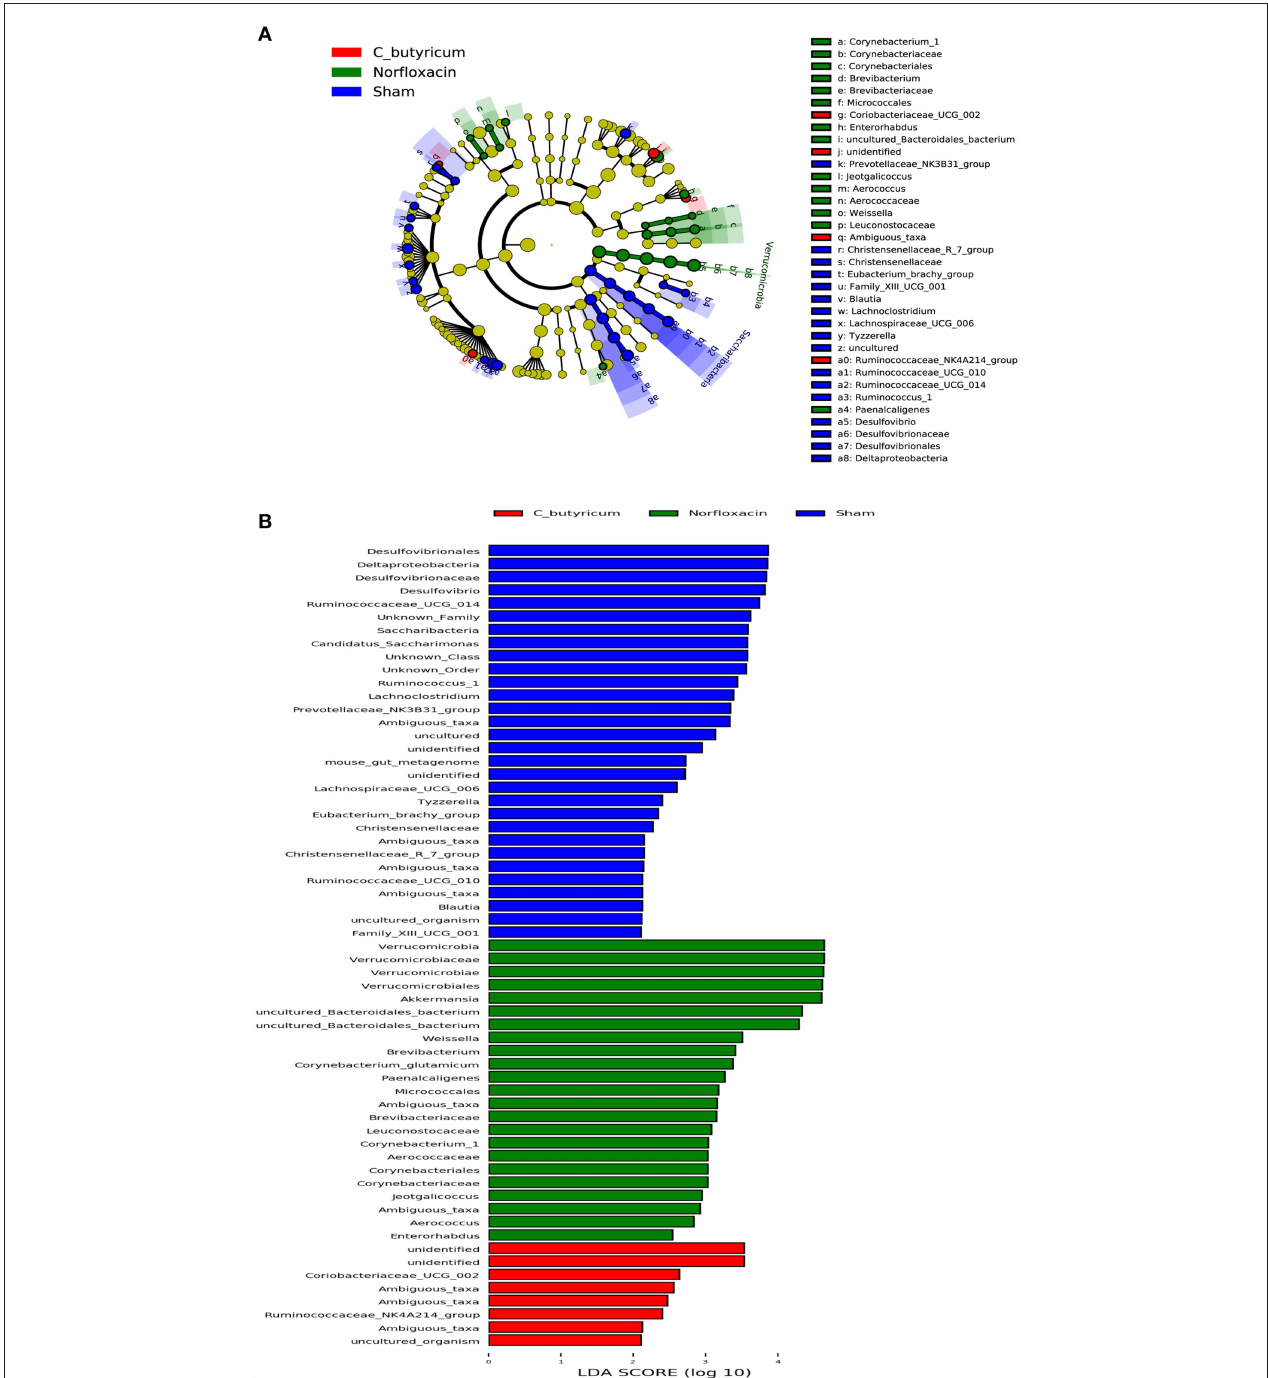
FIGURE 3 | Identification of differential microbes in response to C.butyricum and norfloxacin treatment in mice based on the linear discriminant analysis (LDA) and effect size (LEfSe) pipeline. (A) Cladogram using LEfSe method indicated the phylogenetic distribution of gut microbiota associated with mice in three groups. (B) LDA scores showed the significant bacterial differences in three